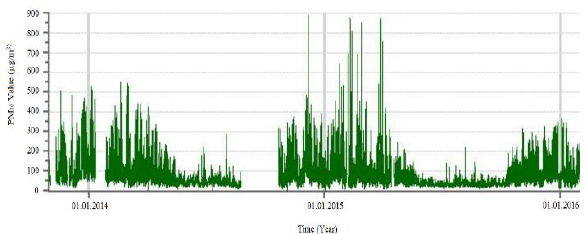
Figure 3. PM 10 time series of Zonguldak for 2014-2016.